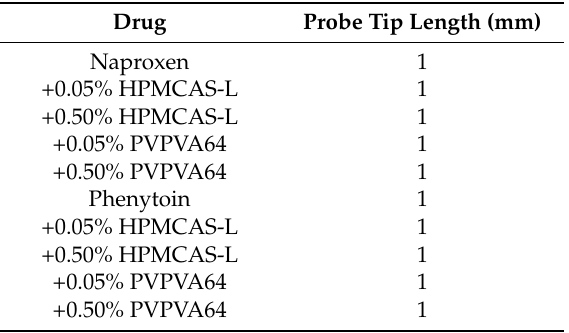
Table A2. Probe tip lengths used in supersaturation